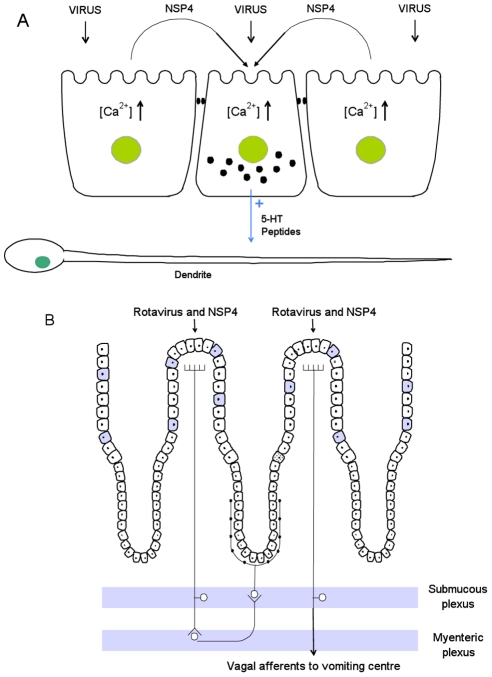
Proposed disease mechanisms for rotavirus infection.Panel A. Interplay between RV, NSP4, EC cells and enteric nervous dendrites. RV infects mature enterocytes evoking the release of NSP4, which together with invading virus, causes the release of 5-HT from EC cells. This, in turn, stimulates nervous dendrites located adjacent to the EC cells. Panel B. Physiological effects of 5-HT release from EC cells. It seems possible that the released 5-HT may activate both intrinsic afferents of the ENS as well as extrinsic afferent nerves. It is proposed that the stimulated intrinsic afferents constitute part of a nervous secretory reflex within ENS (left part of panel B), causing an intestinal fluid loss. Stimulation of extrinsic vagal afferents, activates NTS, a brain structure associated with nausea and vomiting (right part of panel B). The picture depicts the simplest nervous, secretory model that can be constructed on the basis of current experimental observations. Filled cells represent EC cells.